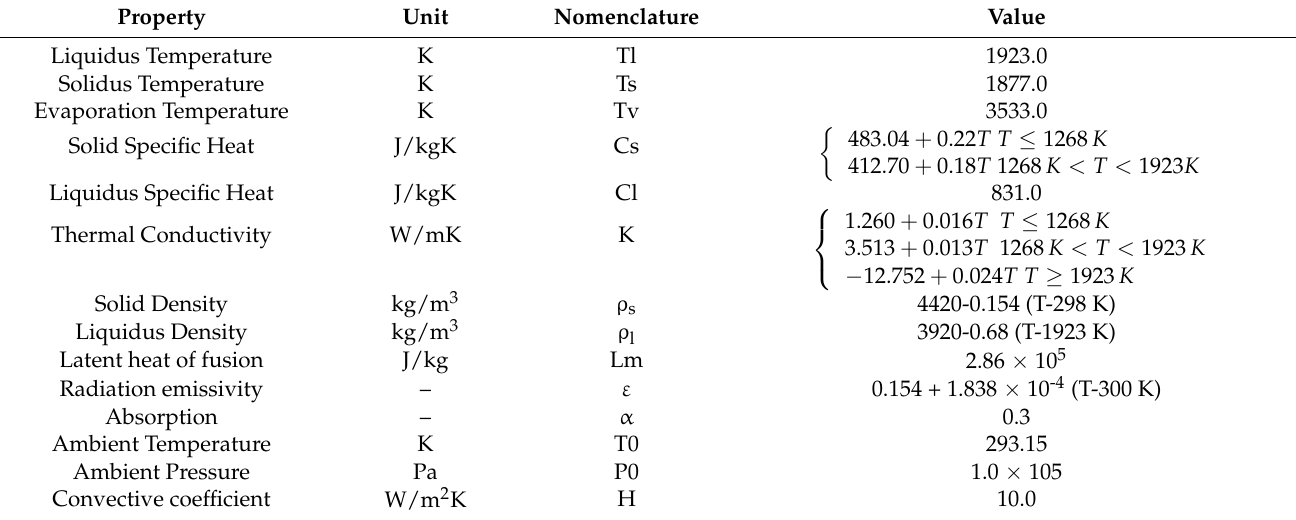
Table A1. Material Properties of Ti-6Al-4V–Adopted from Mills (2002)